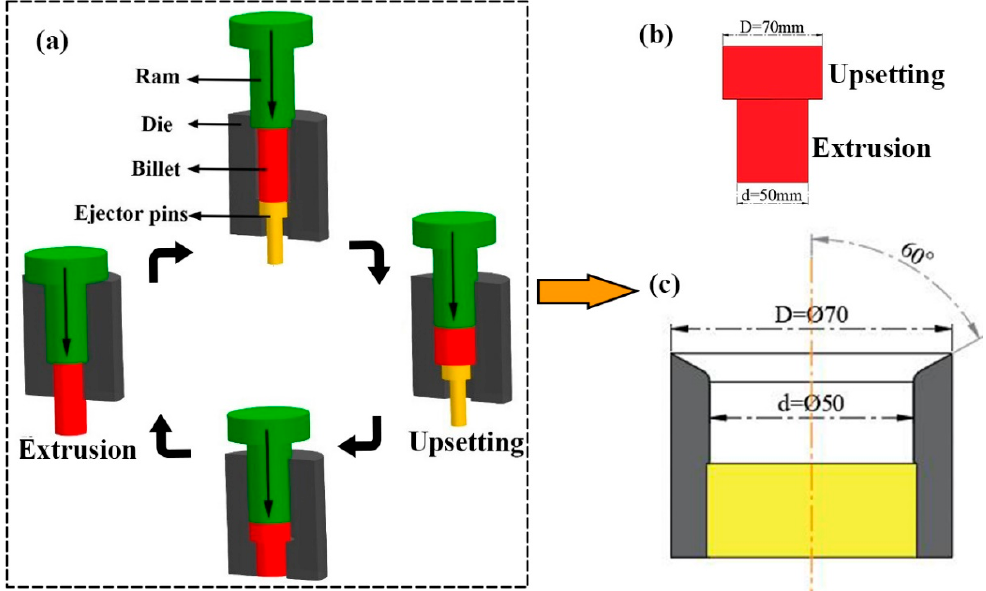
Figure 1. The schematic diagram of Reciprocating Upsetting-Extrusion (RUE) deformation ( a ), sample schematic diagram after upsetting and extrusion ( b ), and the dimension of the extrusion die ( c ).